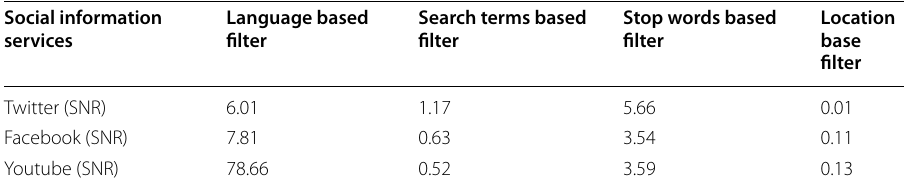
Table 2 Evaluation of data filtering